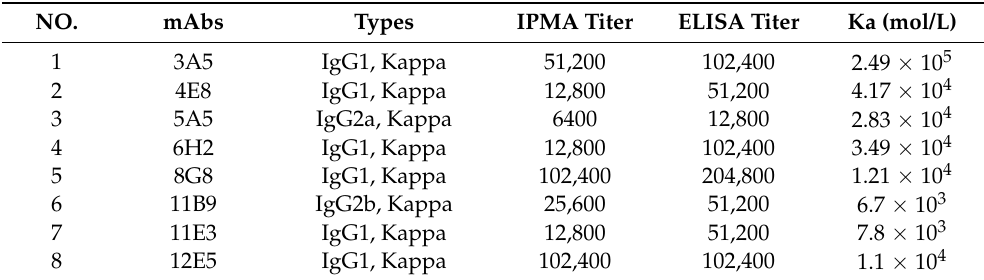
Figure 2. Screening of mAbs against the H9N2 AIV and HA protein. ( A ) Screening mAbs by IPMA. Eight mAbs, 3A5, 4E8, 5A5, 6H2, 8G8, 11B9, 11E3, and 12E5 were identified. ( B ) ELISA results for reaction of mAbs with the HA protein. PC, H9N2 AIV-positive chicken serum. NC, SP2/0 cell culture supernatants. Table 3. Characteristics of